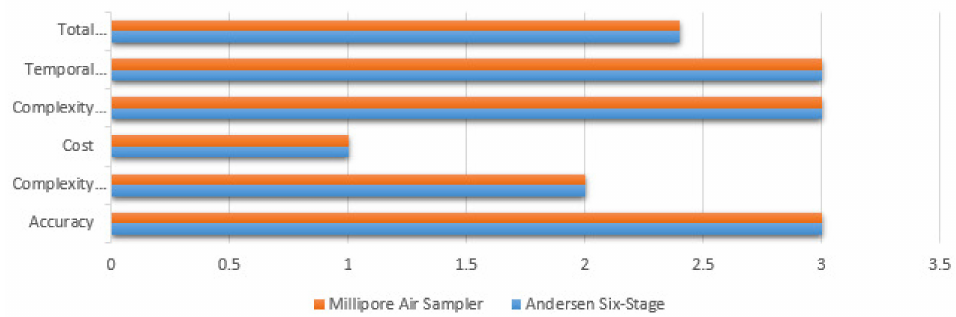
Figure 2. Average scores between passive sampling methods.